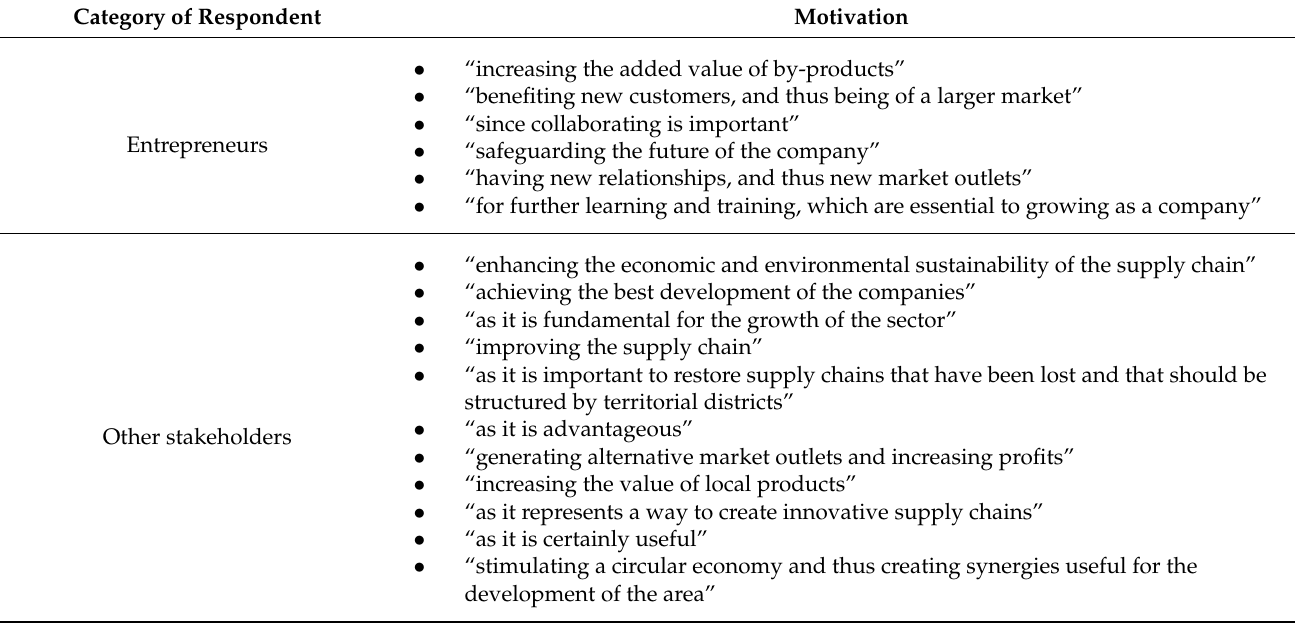
Table 2. Motivations to support network and cooperation in the Salerno